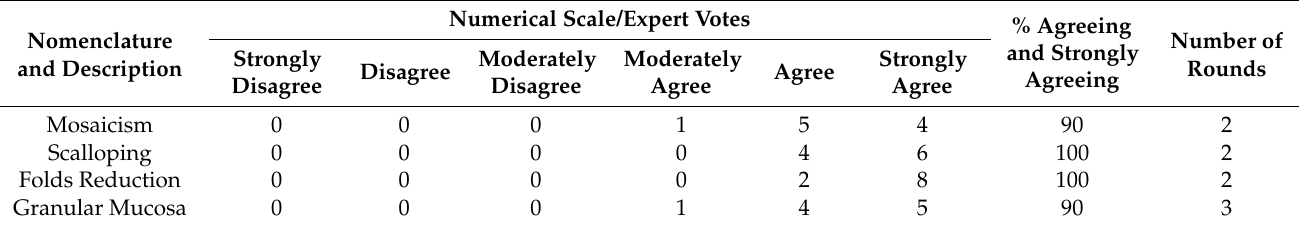
Table 2. Core group rating on the nomenclature and description of common atrophic lesions.